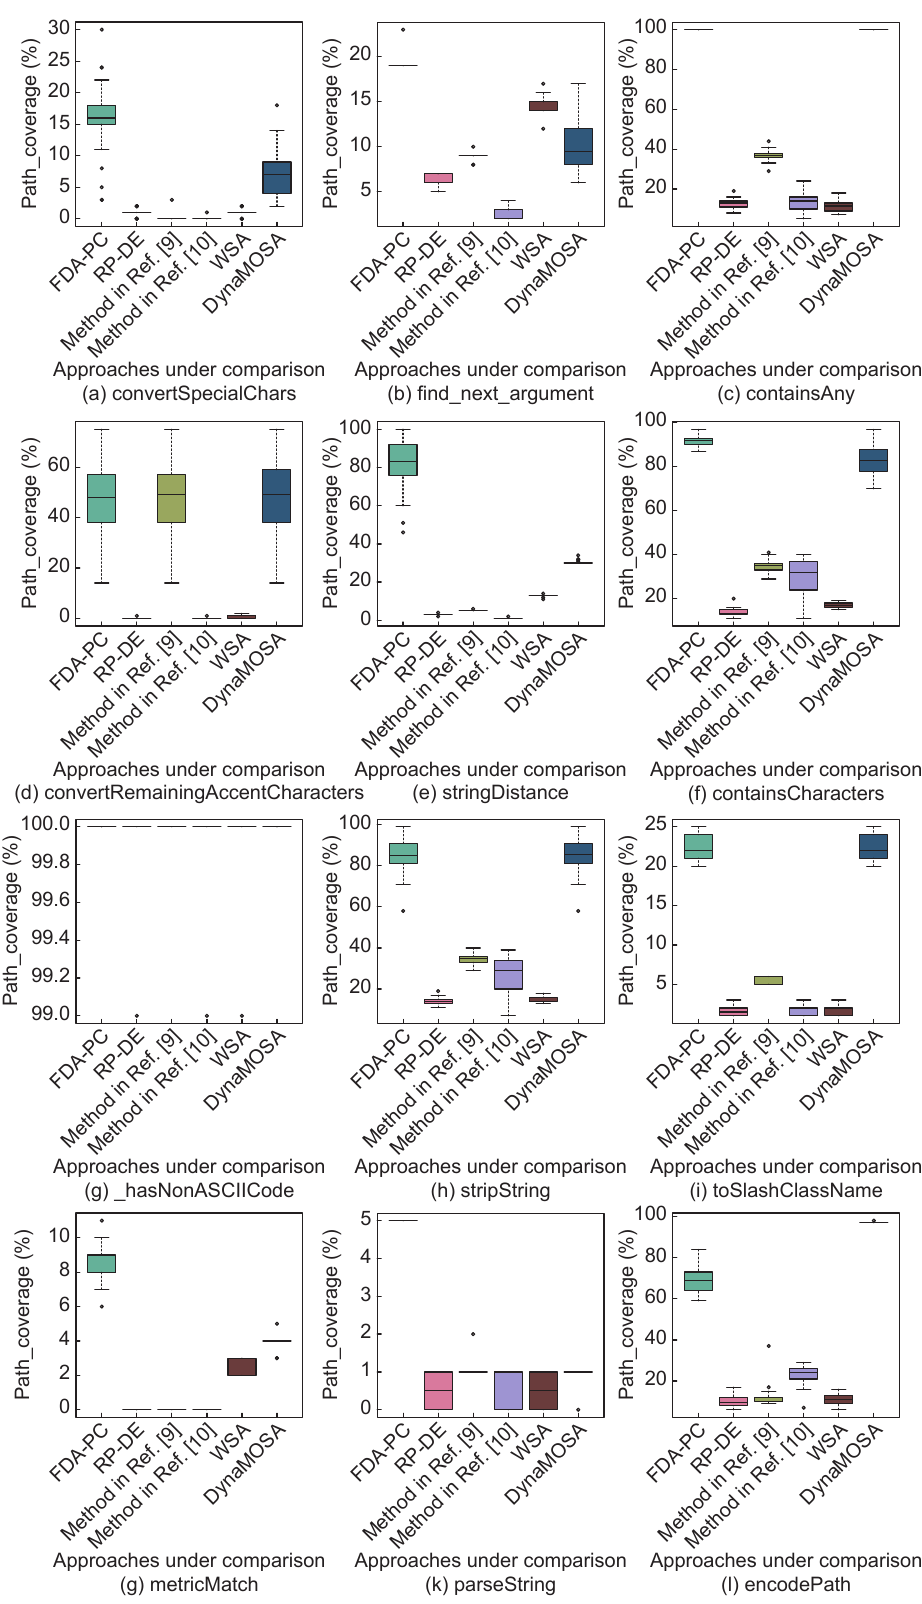
Fig. 5 Box plots for convertSpecialChars, find_next_argument, containsAny, convertRemainingAccentCharacters, stringDistance, containsCharacters, _hasNonASCIICode, stripString, toSlashClassName, metricMatch, parseString, and